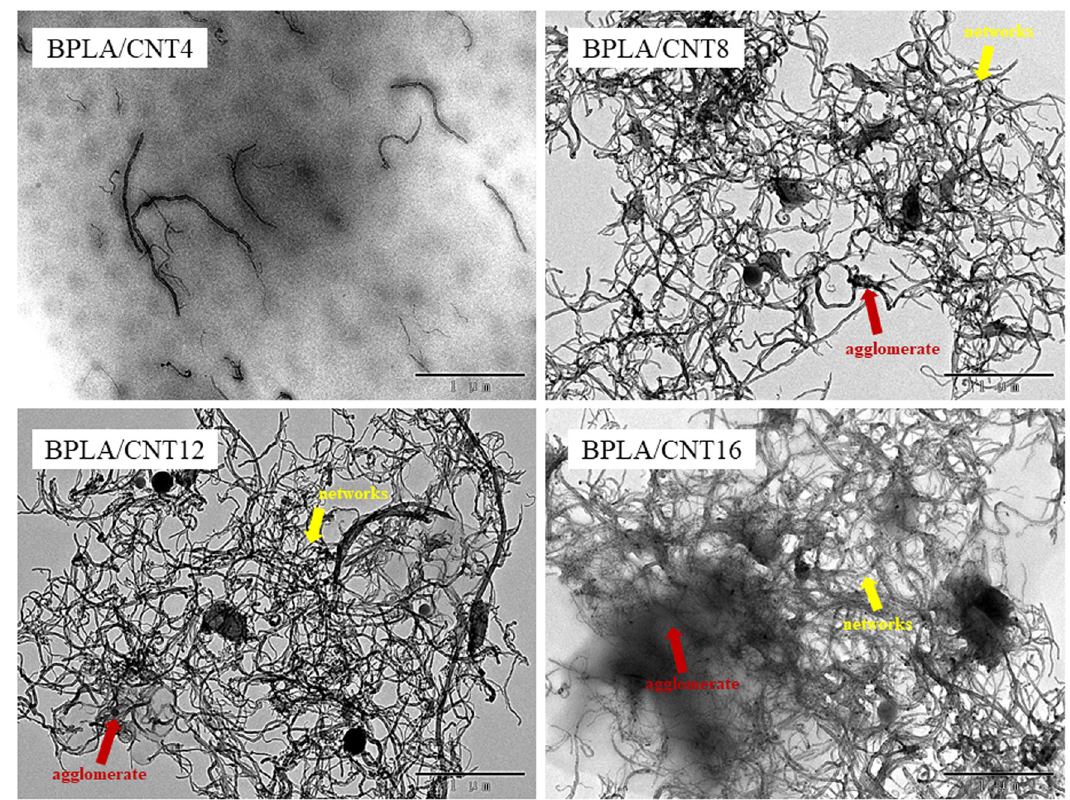
Figure 2: TEM images of BPLA/CNT composites.